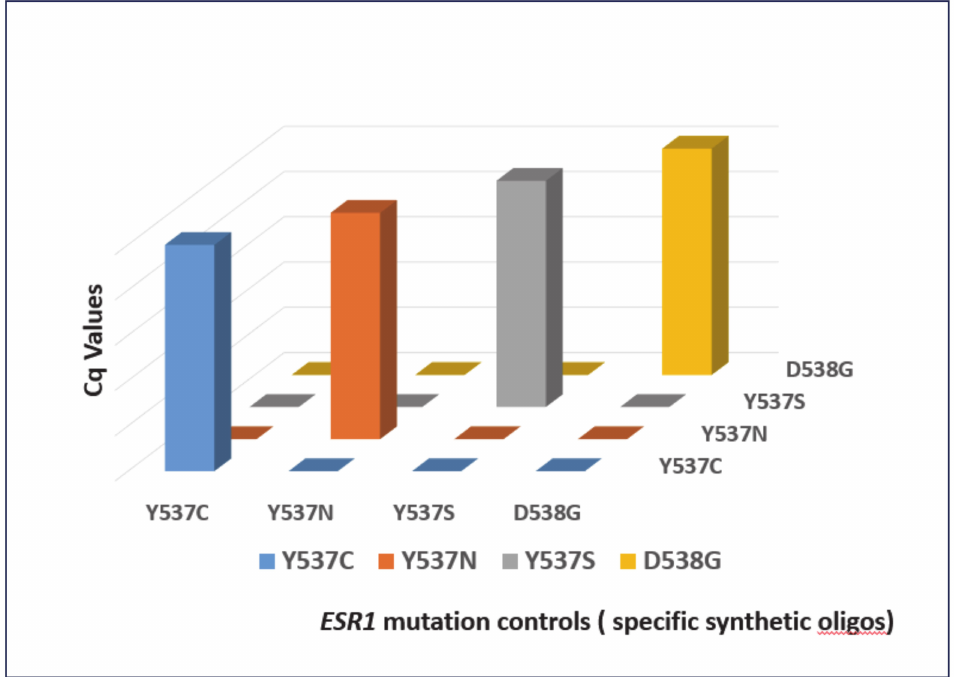
Figure 3. Analytical Specificity of the ESR1 NAPA assay: blue: Y537C; red: Y537N; grey: Y537S; yellow: D538G. All of the experiments were performed in